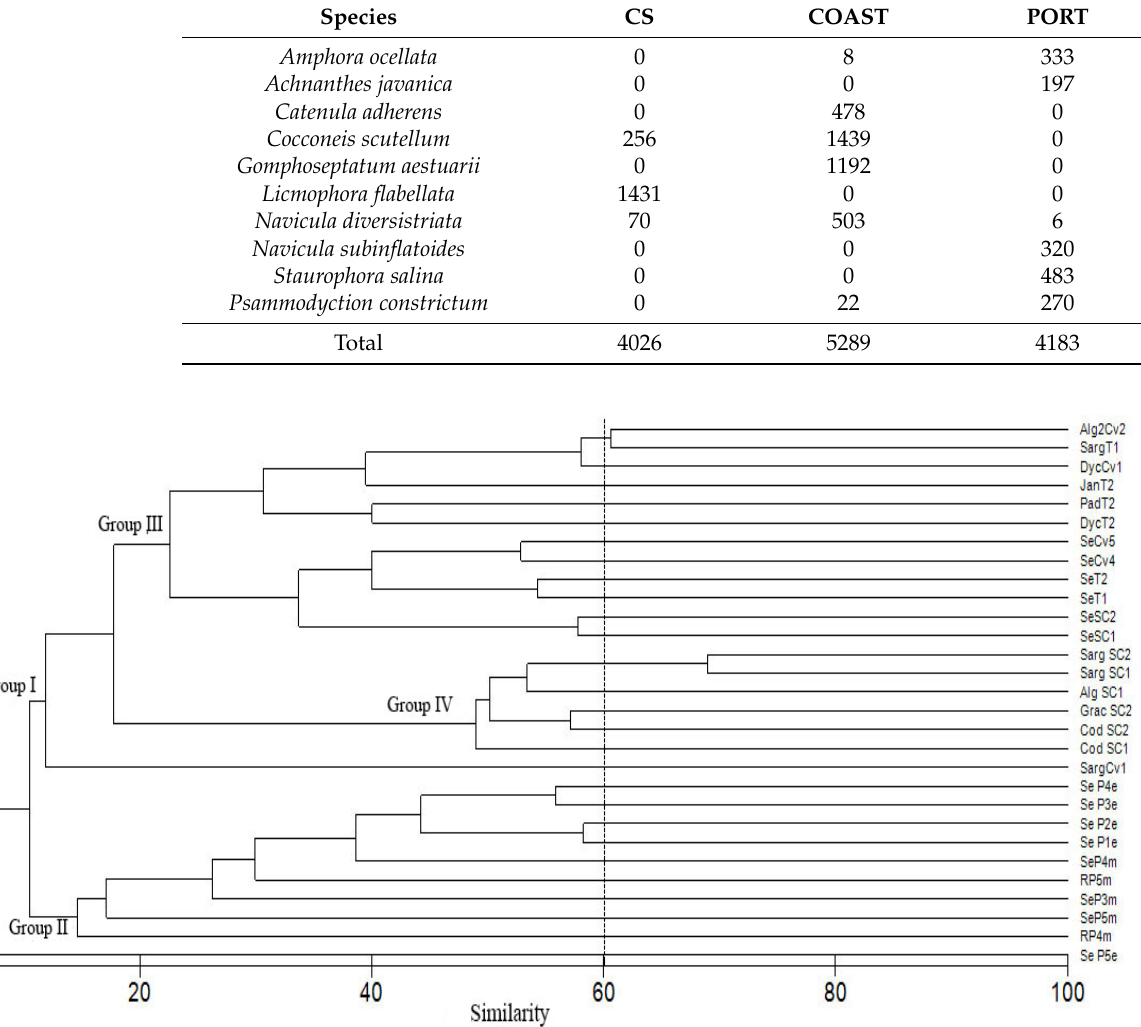
Table 4. Abundances of benthic diatoms (N = 9472) in all substrates at control site (CS), Coast